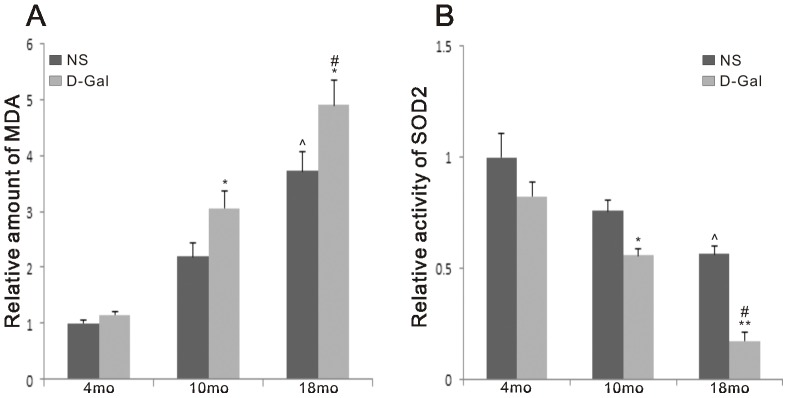
MDA levels and SOD2 activity in the auditory cortex.Effects of age and D-Gal on MDA levels and SOD2 activity in the auditory cortex. The level of MDA was increased in the D-Gal groups, while the activity of SOD2 was decreased in the D-Gal groups. *Significantly different from the NS groups (*P<0.05, **P<0.01). ∧Significantly different from the 4-month-old NS group (P<0.01). #Significantly different from the 4-month-old D-Gal group (P<0.01).